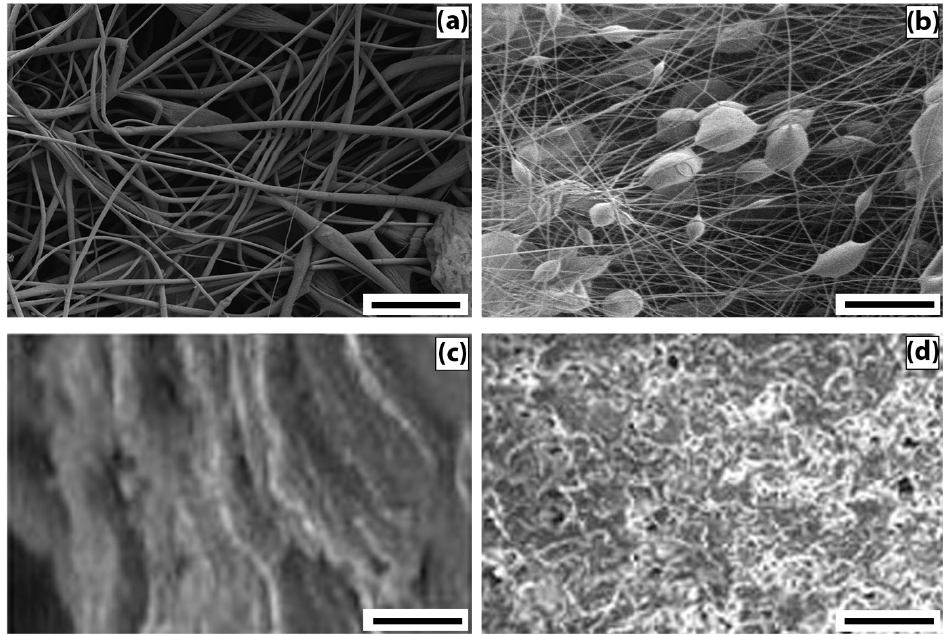
Figure 1. Images of the morphology of samples of nonwoven fibrous and film materials obtained by SEM: ( a ) PHB—fibers, ( b ) PHB/CHT—fibers (60/40), ( c ) PHB/CHT—film (50/50), and ( d ) PHB—film. The size of the scale bar—100 µm.